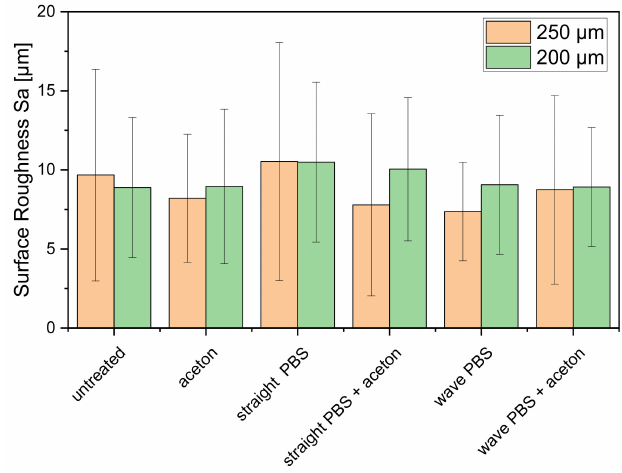
Figure 4. Surface roughness for the 3D-printed round geometries with straight and wavy spokes: untreated, washed in acetone, incubated in PBS for 1 week, and washed in acetone and incubated in PBS for 1 week, depending on the inner diameter of the needle used; n =